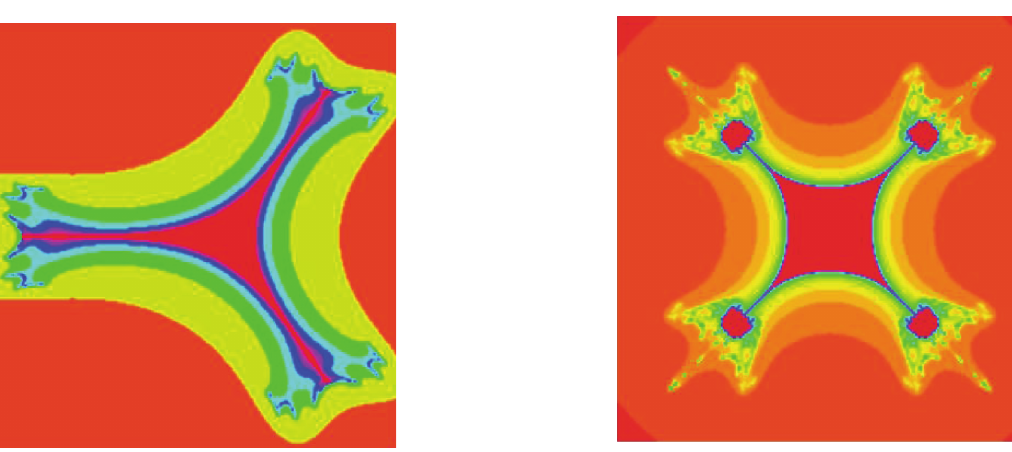
Figure 5: Relative superior tricorn for 𝑠 = 0.4 and 𝑠 󸀠 = 0.7 .